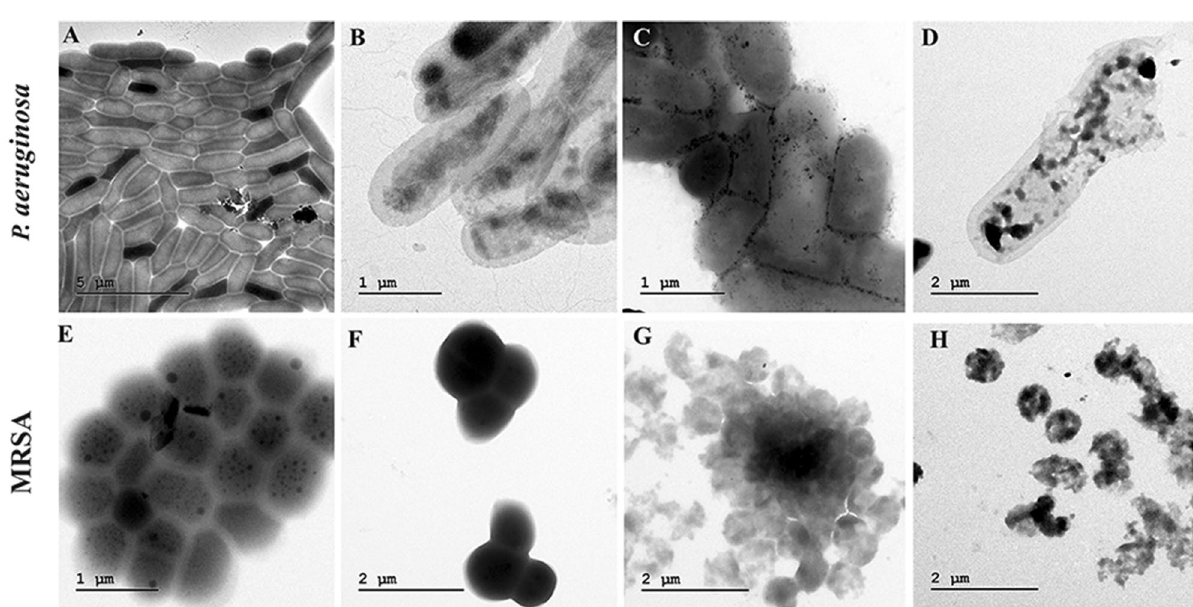
Figure 14. TEM Ultrastructural morphological damages of P.aeruginosa and MRSA biofilms with treatment combinations. ( A , E ) Control biofilms without treatment, ( B , F ) Biofilms treated with LP alone, ( C , G ) Biofilms treated with Cu-NPs alone, ( D , H ) Biofilms treated with LP +